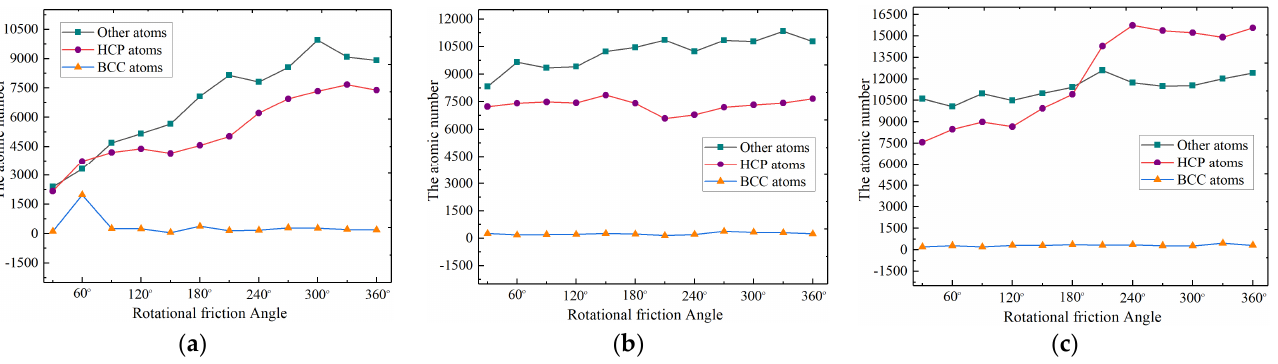
Figure 13. The number of HCP, BCC, and Other defective atom: ( a – c ) are respectively the first friction, the second friction, and the third friction.